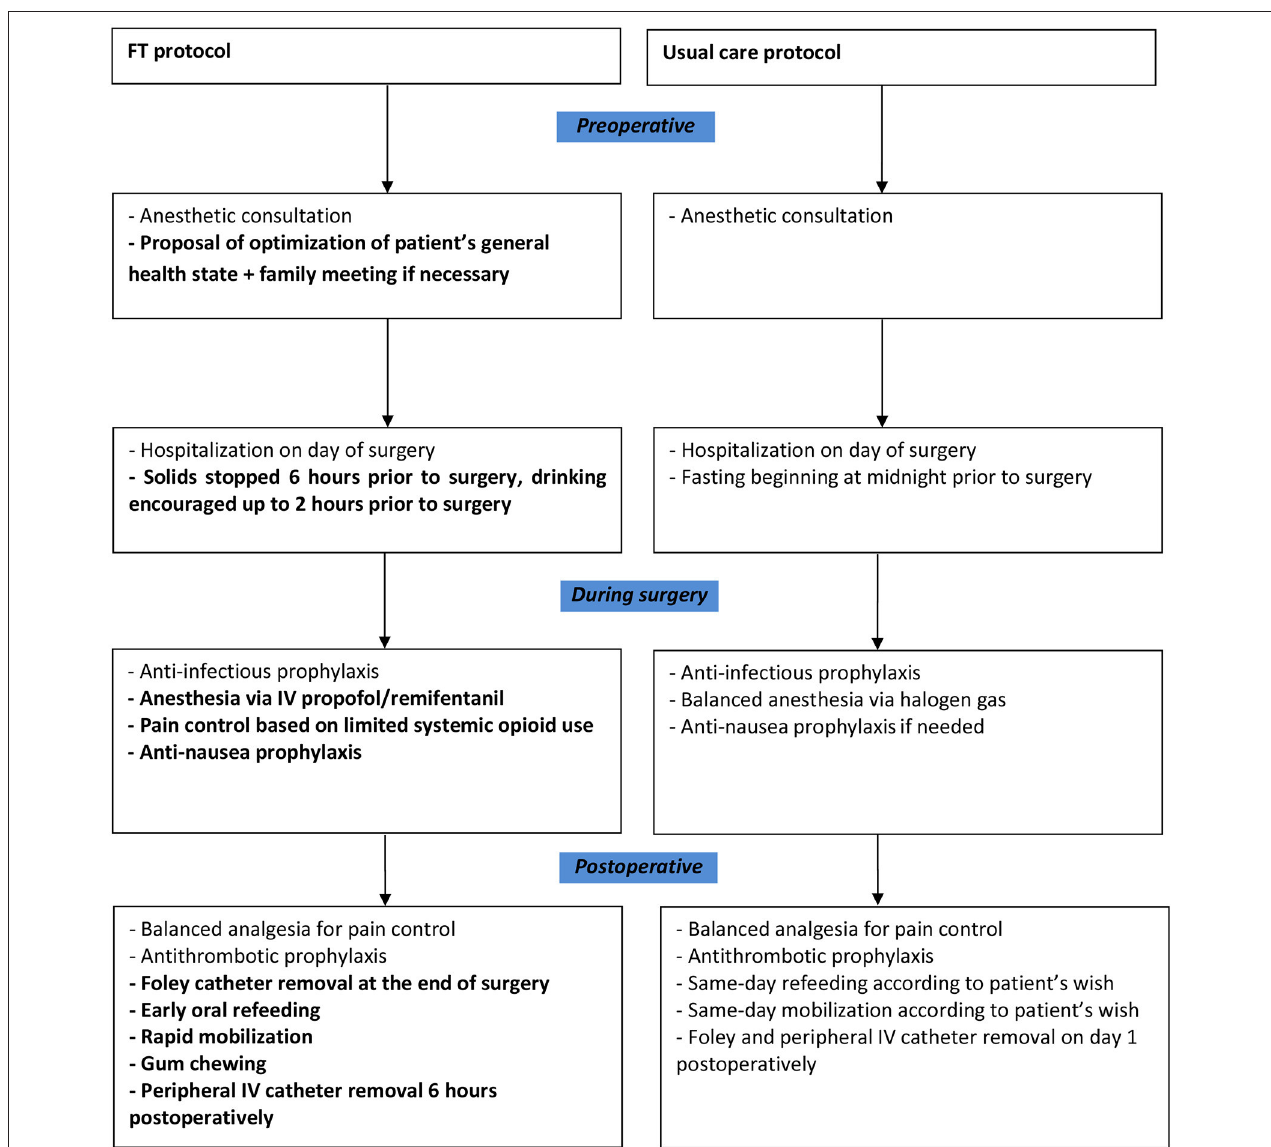
FIGURE 1 | FT and usual care protocol descriptions. Items in the FT protocol that differ from those in the usual care protocol are highlighted in bold. FT, fast-track; IV,